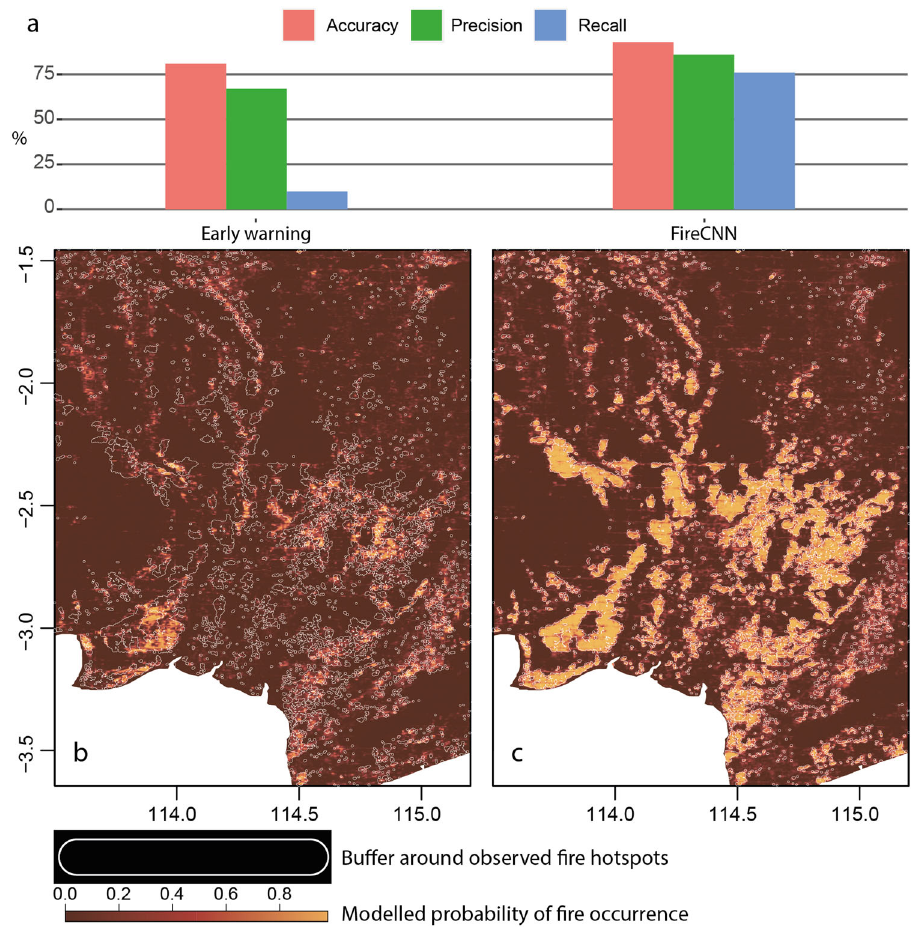
Fig. 5 Comparison of FireCNN and early warning model results for 2019. a Performance metrics of accuracy, precision, and recall for the application to 2019 data of both the early warning model (training data 2002 – 2018) and the FireCNN model (training data 2002 – 2019). b Output map of 2019 modelled fi re occurrence probabilities (0 – 1) for the early warning model (2019 excluded from training dataset). c Output map of 2019 modelled fi re occurrence probabilities (0 – 1) for the FireCNN model (2019 included in training dataset). Both a and b have buffer zones indicating where the observed (MODIS and VIIRS) hotspot data is located in white outlines. Accuracy is the percentage of all model estimates that are correct ( fi re and not- fi re), precision is